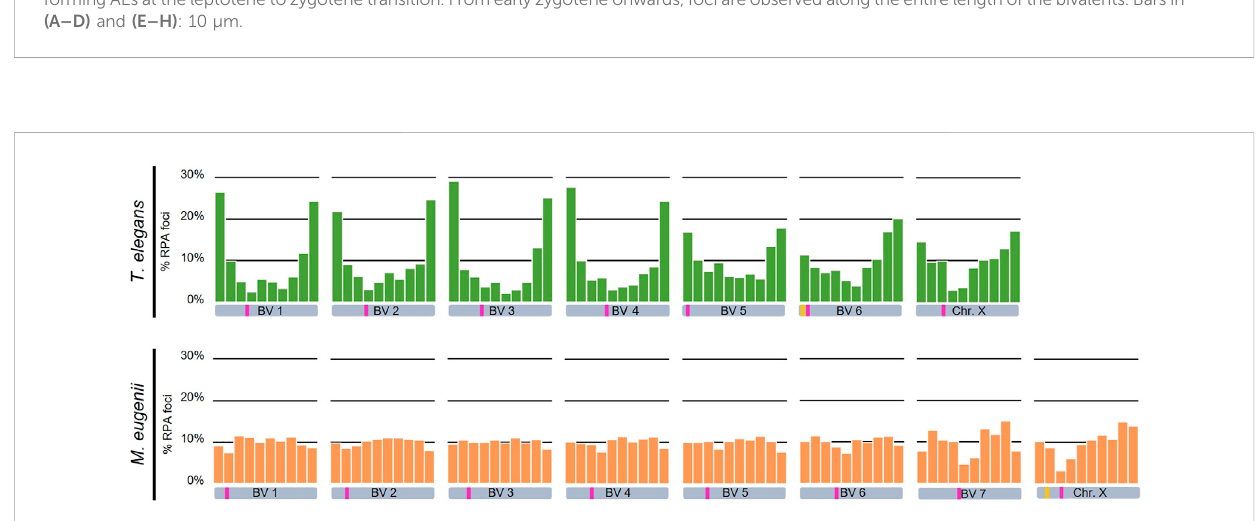
FIGURE 8 Chromosomal distribution of RPA foci distribution along bivalents and the X chromosome in Thylamys elegans and Macropus eugenii . Chromosomes have been divided into 10 segments of equal size between telomeres (proximal to distal). Y -axes in the graphs indicate the percentage of RPA foci in each segment. Each bivalent (BV) has been depicted below the corresponding graph. Pink bars indicate the centromere position, yellow bars indicate the NOR. We found a prominent polarization of RPA foci towards the chromosome ends in Thylamys elegans . In contrast, in Macropus eugenii detection of RPA foci uncovered a relatively homogeneous distribution along the entire length of the